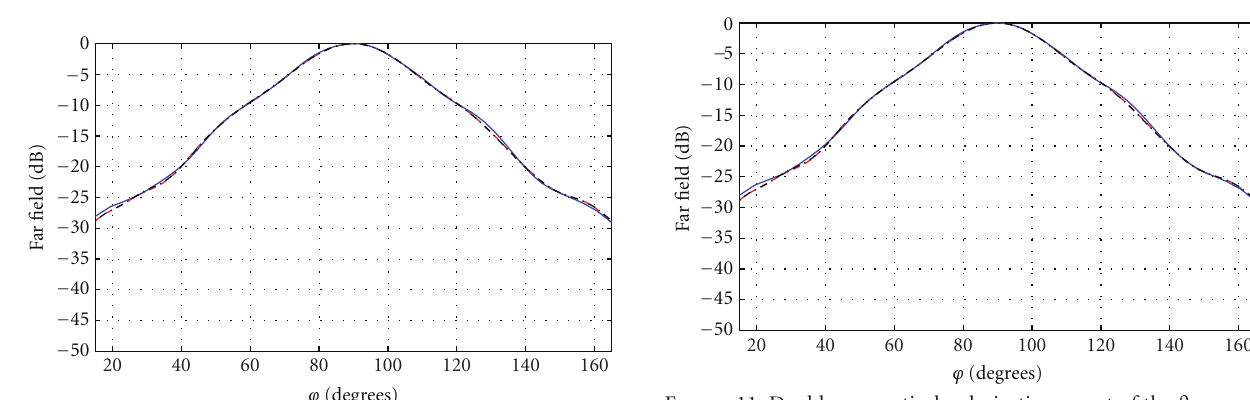
Figure 8: Dual horn, vertical polarization. Singular values.